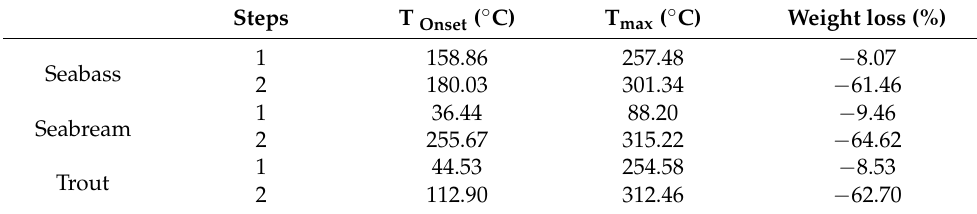
Table 4. Values obtained from TGA and DTGA analysis of seabass, seabream and trout. Onset